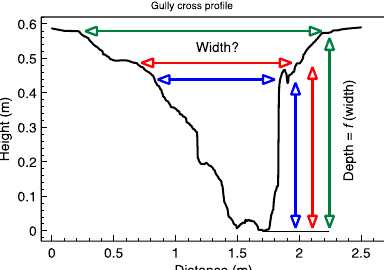
width is defined by the imaginary line whose ends are lo-